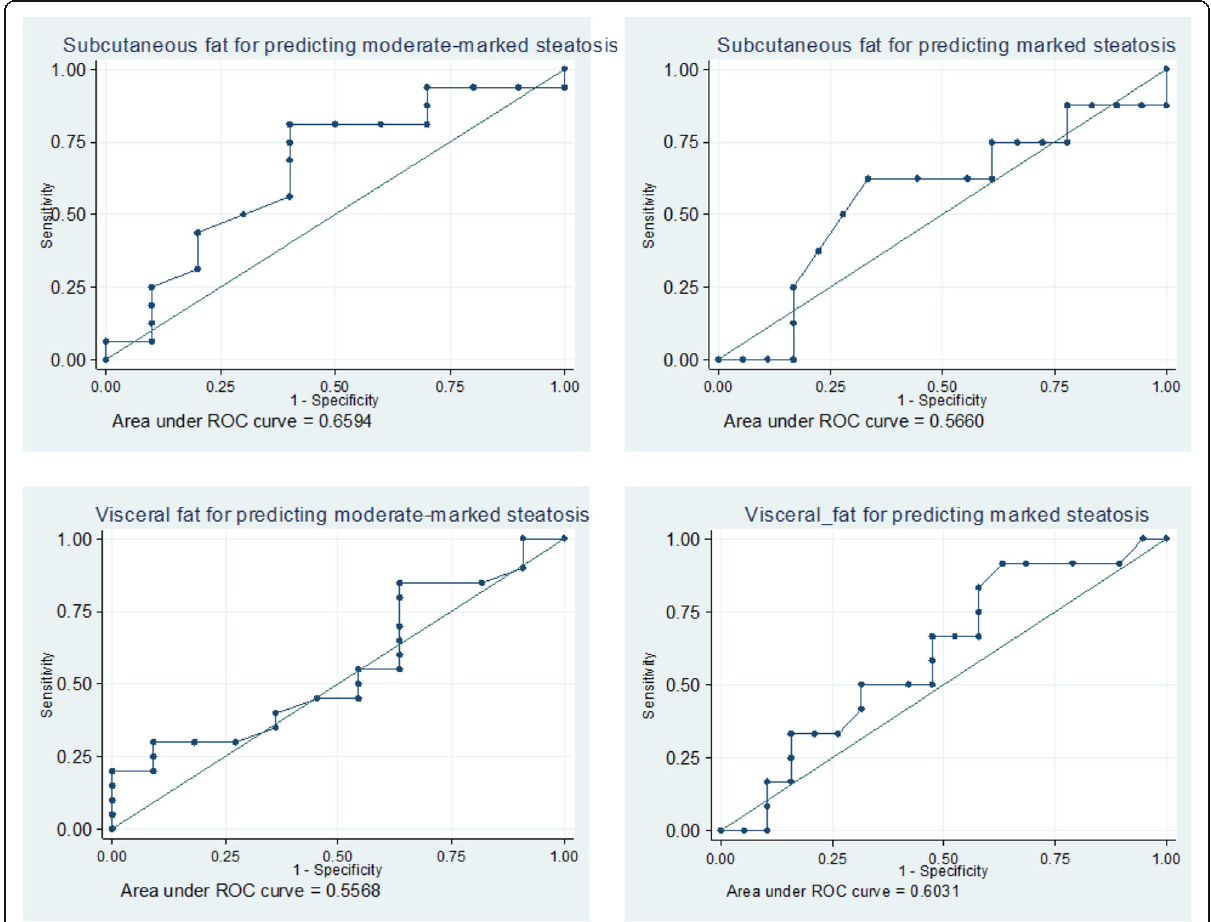
Fig. 3 ROC curve for SAT and VAT in the prediction of moderate/marked